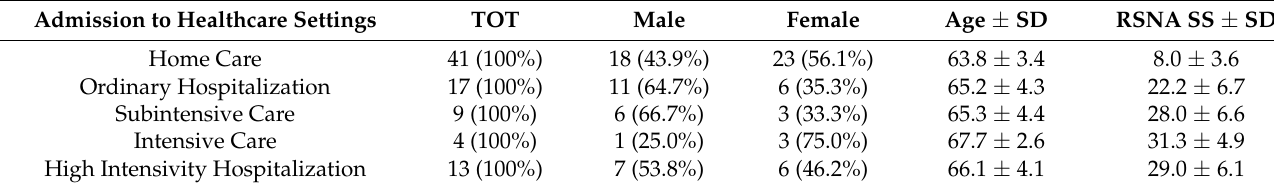
Table 2. It shows CT, gender, and sex characteristics of patients grouped by type of admission; the data are represented by mean with standard deviation, absolute number and frequency. RSNA SS: RSNA severity score; High Intensivity Hospitalization (Subintensive Care + Intensive Care); SD: Standard